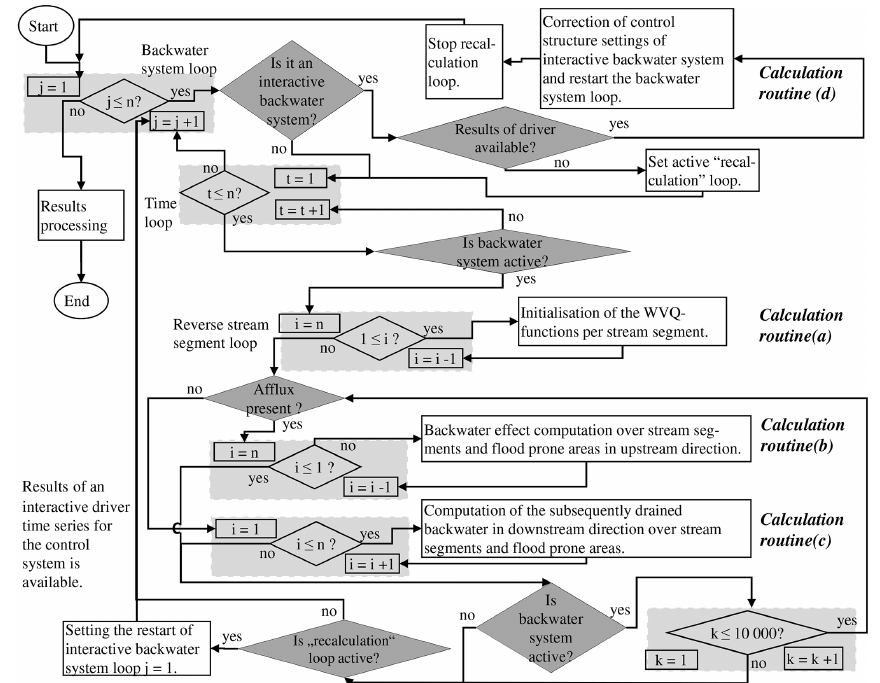
Figure 5. Algorithm to compute backwater effects in streams and lowland areas (like retention areas) with the indicated calculation routines (a, b, c, d). It is realised with a space-before-time algorithm for modelling backwater effects and control structures per backwater